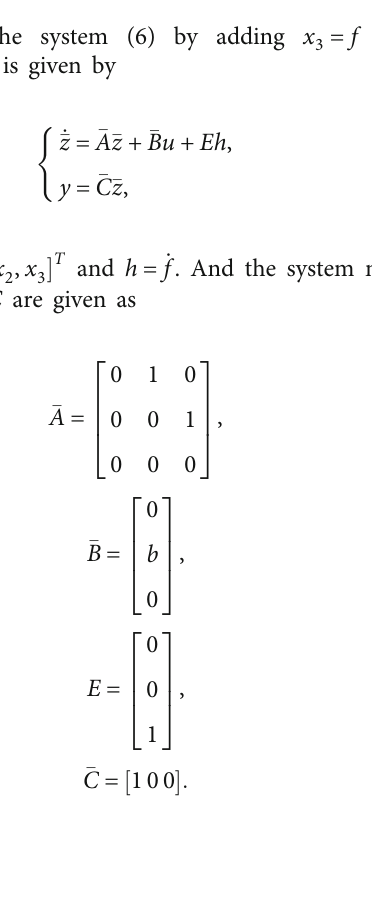
Figure 2: Measurement of principal moments of inertia by using a bi fi lar